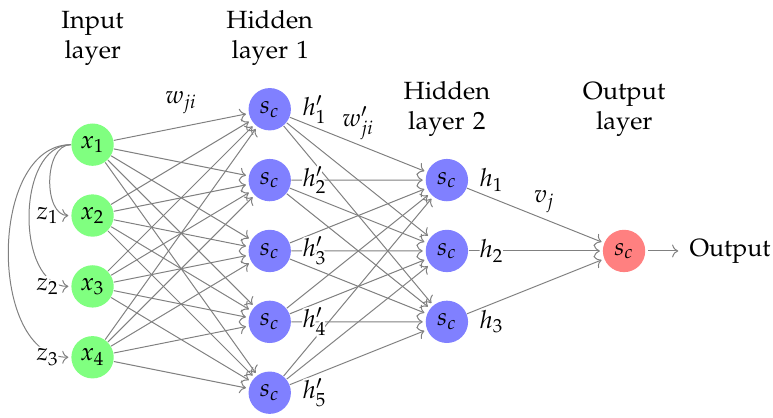
Figure 5. Schematic of a neural network with two hidden layers and a four element sliding window, where s c denotes the sigmoid activation function and w ji , w (cid:48)